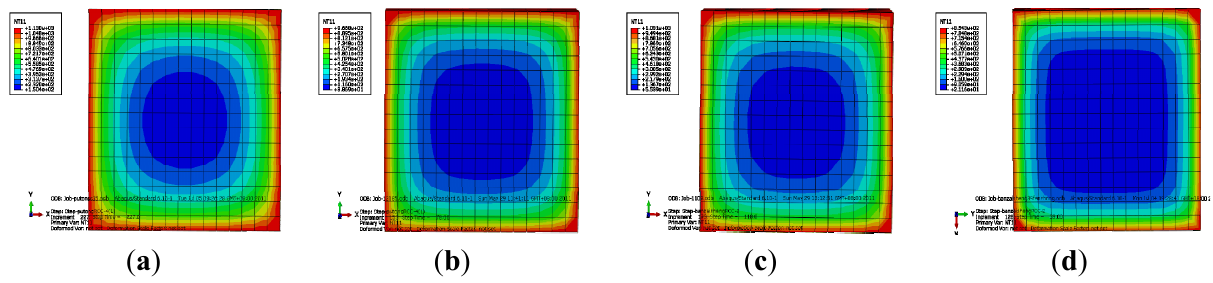
Figure 15. Moire pattern of temperature of specimens: ( a ) NCC-1; ( b ) NCC-2; ( c ) RCC-1; and ( d ) RCC-2.